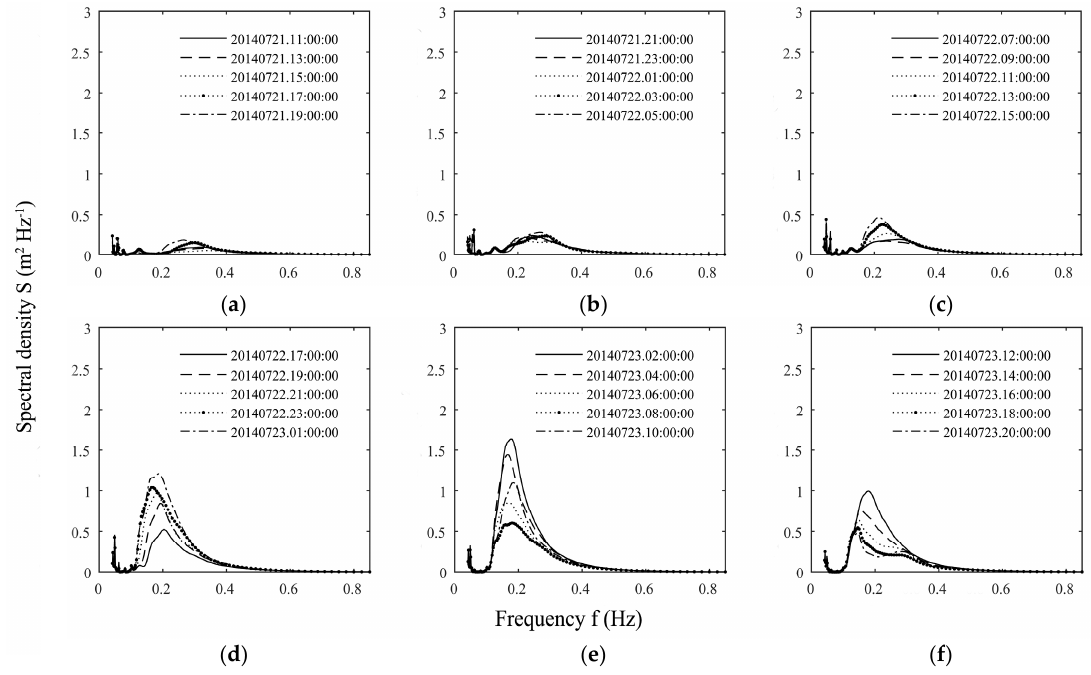
Figure 6. SWAN simulated wave spectra at Wankou buoy position during the passage of Typhoon Matmo from 21 to 23 July 2014: ( a ) from 11:00, 21 July 2014 to 19:00, 21 July 2014; ( b ) from 21:00, 21 July 2014 to 05:00, 22 July 2014; ( c ) from 07:00, 22 July 2014 to 15:00, 22 July 2014; ( d ) from 17:00, 22 July 2014 to 01:00, 23 July 2014; ( e ) from 02:00, 23 July 2014 to 10:00, 23 July 2014; and ( f ) from 12:00, 23 July 2014 to 20:00, 23 July 2014.